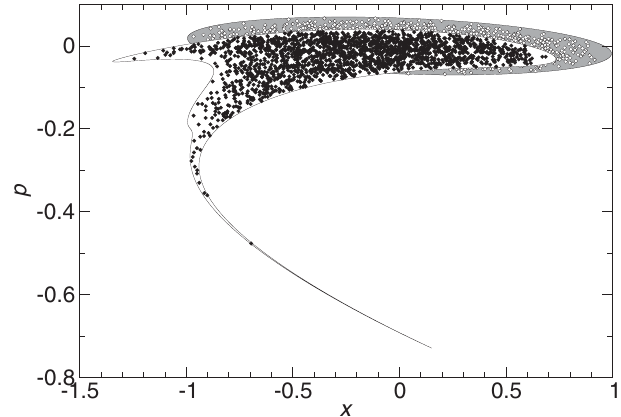
FIG. 13. Initial (white circles) and final (black circles) distri- butions, where the desired emittance growth is 10%. The gray ellipse denotes the 3 (cid:6) boundary, and that same boundary for the final distribution is shown surrounding the black